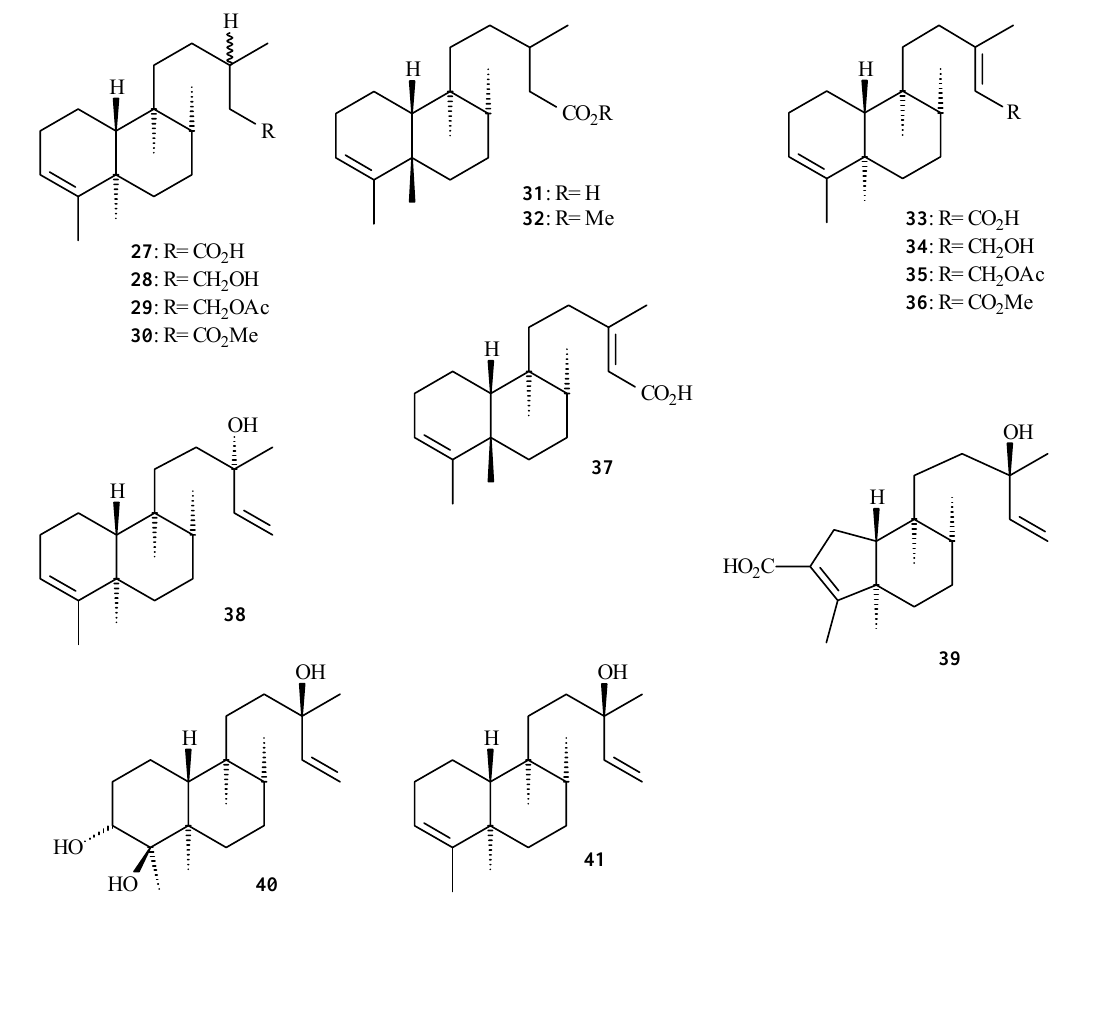
Figure 4. Clerodane diterpenoids isolated from Aristolochia